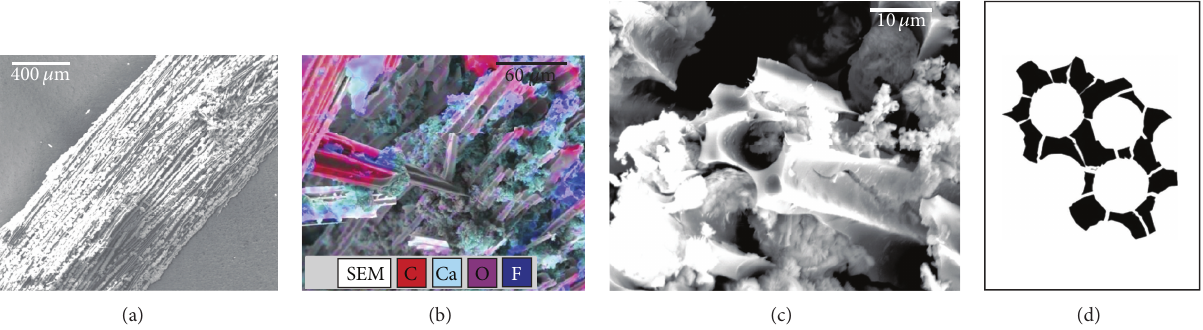
Figure 3: (a) Scanning electron microscopic (SEM) images of agglomerated carbon tubes; (b) energy dispersive X-ray (EDX) image of those tubes, (c) SEM image of a single tube and its surrounding, and (d) scheme of porous, agglomerated carbon tubes from glass fibre and 1